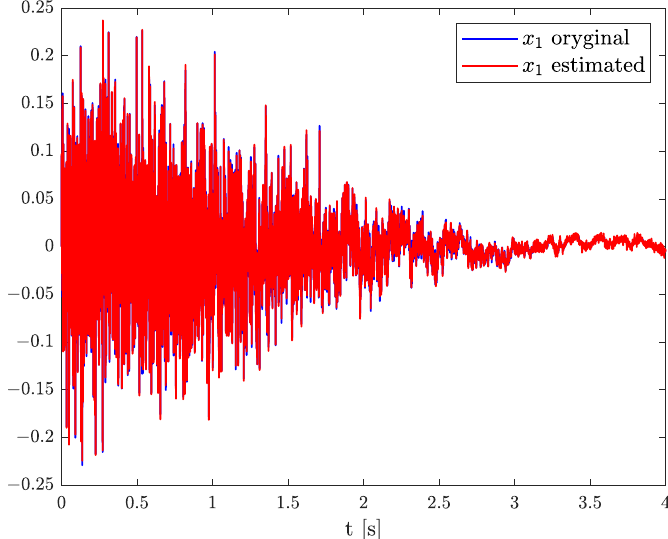
Figure 8. Original and estimated state variable from Example 3.